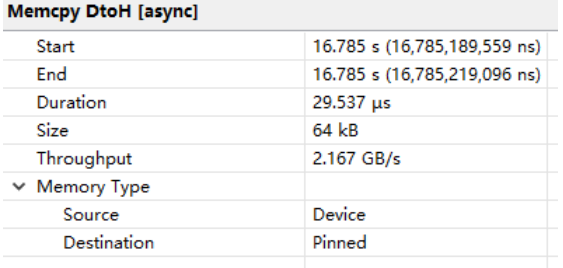
Fig. 12. The Memcpy DtoH properties on calculating the potentials.